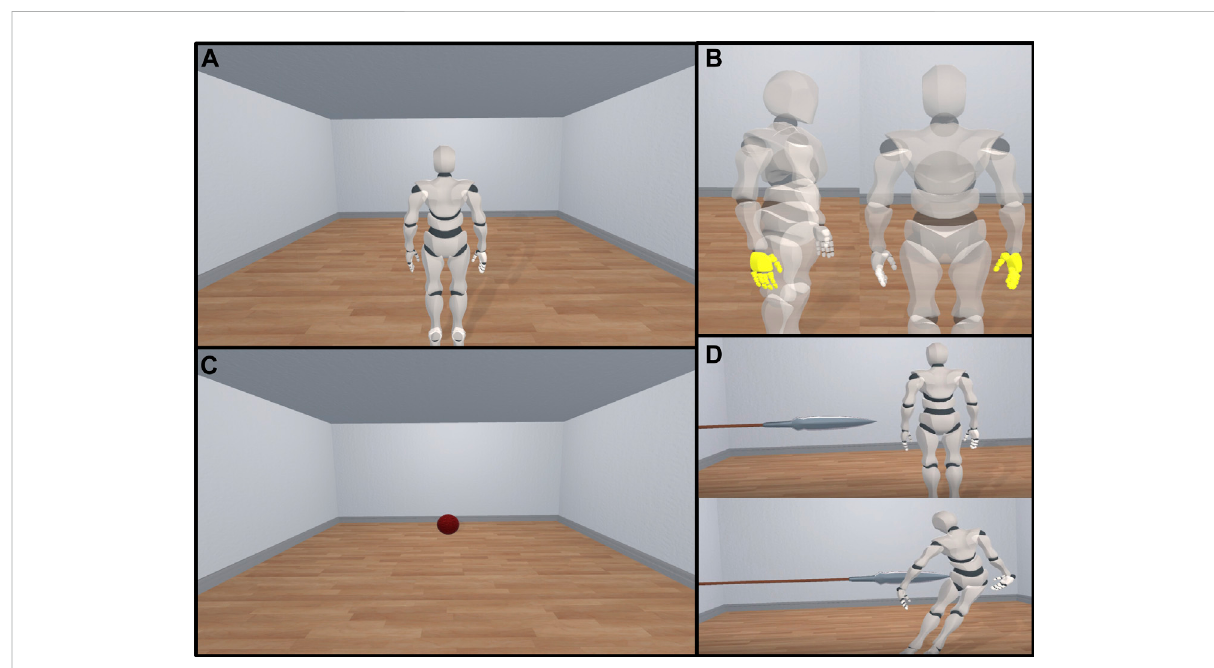
FIGURE 1 View of the avatar and the three tasks used in Virtual Reality. (A) View of the avatar in the head-mounted display as perceived by the participant. (B) Ball appearing at the back of the room and moving toward the participant during the mental imagery task to quantify self-location. (C) Avatar displayedat120 ° (left)and0 ° (right)angleswiththerighthandhighlightedduringtheown-bodytransformationtasktoquantifyperspectivetaking. (D) The avatar slowly approached then pierced by a spear to induce heart rate deceleration used as a measure of self-identi fi